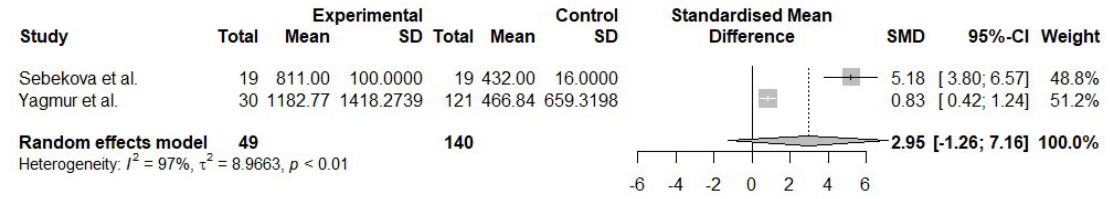
Figure 4. Pairwise comparisons of serum AGE (CML) levels between patients with ALD and healthy controls [38,39].